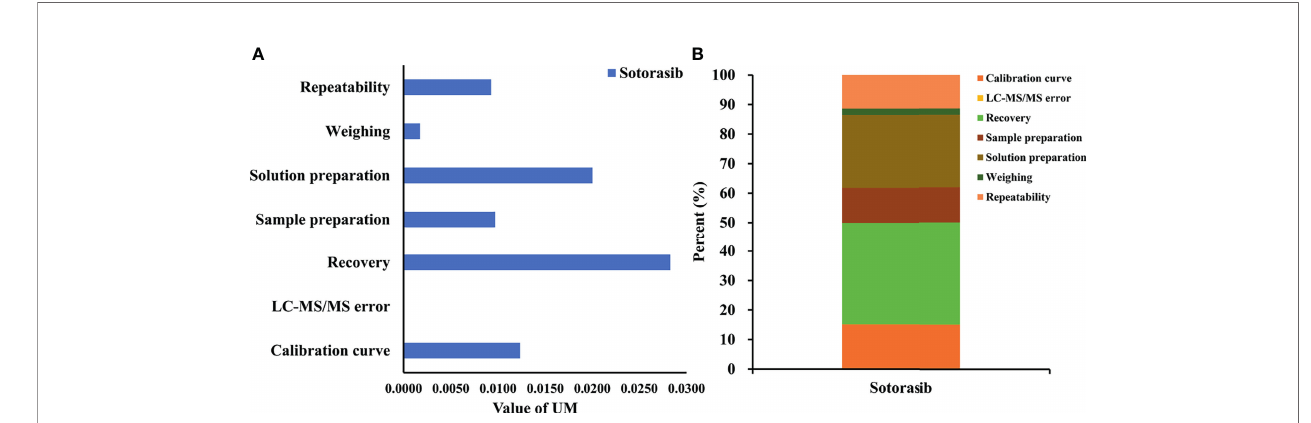
FIGURE 3 | Uncertainty of measurement and proportion for determining sotorasib at a concentration of 20 ng/ml. (A) Statistical histogram of the uncertainty components. (B) The percentage of each element in the uncertainty components.